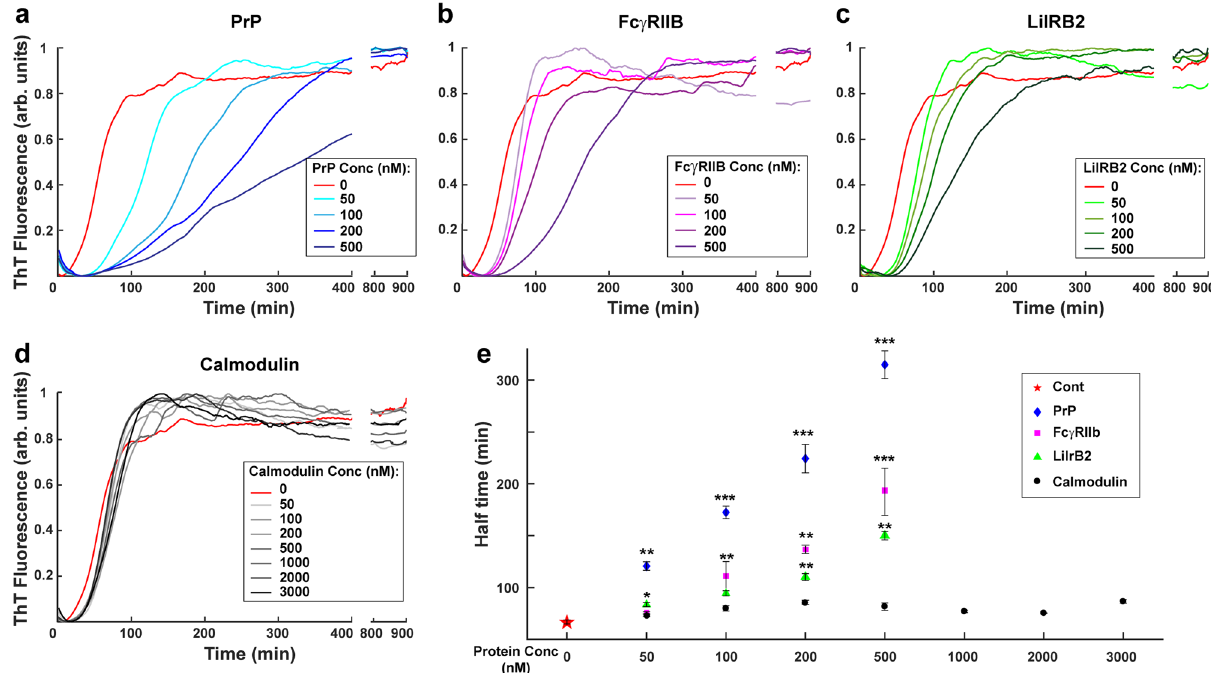
Fig. 7 Fc γ RIIb and LilrB2 affect the kinetics of A β polymerization in a manner similar to PrP. ThT curves for polymerization of unlabeled A β (5 μ M) in the presence of increasing concentrations of recombinant PrP ( a ), Fc γ RIIb ( b ), LilrB2 ( c ) and calmodulin ( d ). e Effect of receptors on the half-times for A β polymerization, derived from the data in ( a – d ). Data represent mean ± S.E. Half-time values that are signi fi cantly different from control are indicated: * P < 0.05, ** P < 0.01, and *** P < 0.001 (two-sided Student ’ s t-test). Each curve shown in a – d is the average of 3 replicates, and each condition repeated at least